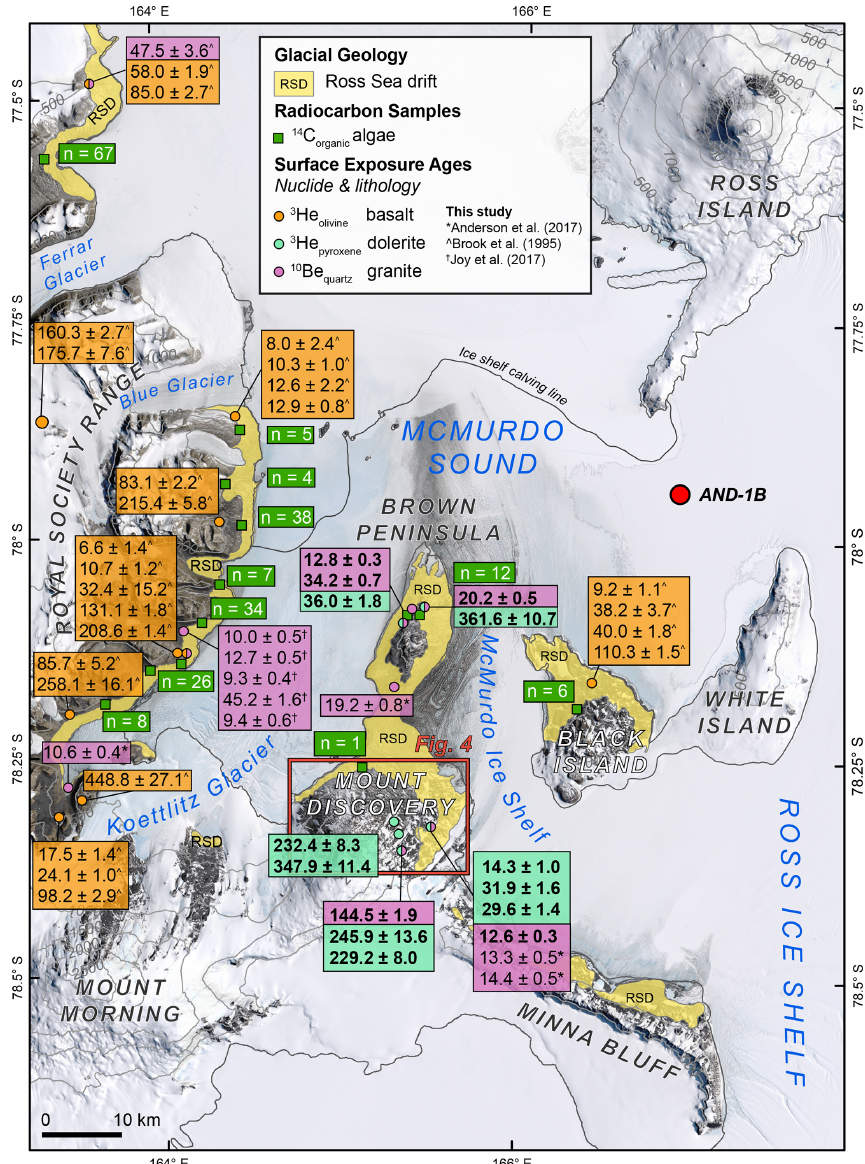
Figure 2. Compiled cosmogenic nuclide exposure ages and radiocarbon sample locations in the McMurdo Sound region. The extent of Ross Sea drift from is shown. The number of calibrated radiocarbon ages of Ross Sea drift are shown in green boxes (Christ and Bierman, 2020; Hall et al., 2015; Hall and Denton, 2000; Jackson et al., 2018). All exposure ages from this study and previously published data (Anderson et al., 2017; Brook et al., 1995; Joy et al., 2017) were recalculated using the same LSDn scaling scheme (Lifton et al., 2014) and shown here as the exposure age ± 1 σ internal uncertainty from previous studies. Extent of Fig. 4 shown in white for detailed mapping on Mount Discovery. AND-1B drill core (red circle) shown for reference (McKay et al., 2012). Base map: Landsat Image Mosaic of Antarctica and 500m contours derived from digital elevation models created by the Polar Geospatial Center from DigitalGlobe, Inc. imagery (Howat et al.,